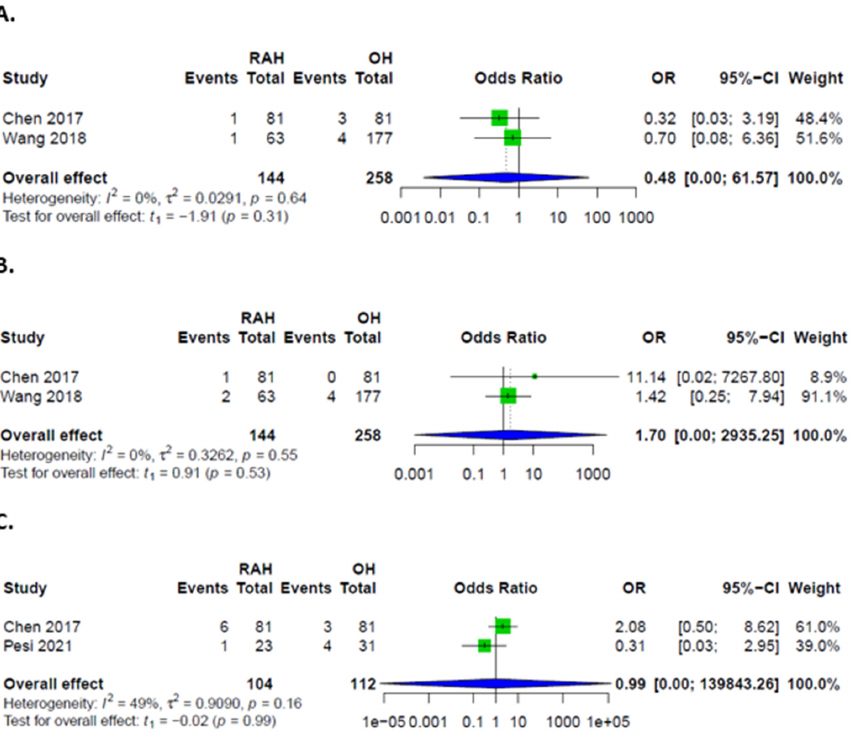
Figure 10. Forest plots for specific complications and interventions; ( A ) Biliary leakages in patients after RAH and OH; ( B ) Postoperative hemorrhages in patients after RAH and OH; ( C ) Intraoperative transfusions in patients after RAH and OH.